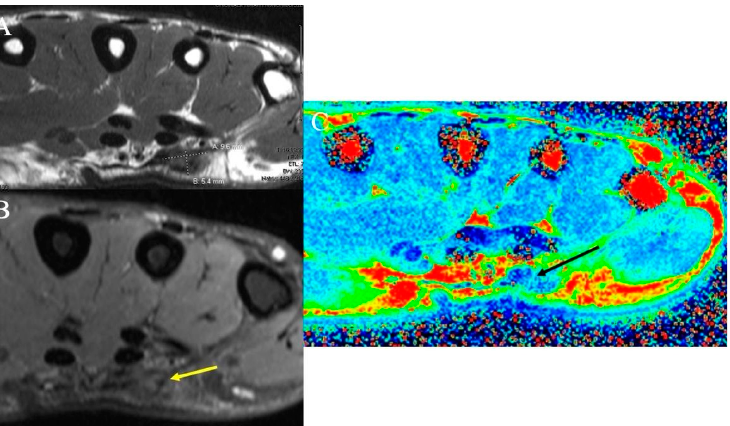
Figure 10. Dupuytren’s disease. ( A ) Axial T1-weighted MR image demonstrating a low-signal mass measuring 9.6 mm × 5.4 mm consistent with the diagnosis of superficial palmar fibromatosis or Dupuytren’s disease. ( B ) Axial fat ‐ suppressed PD ‐ weighted MR image demonstrating the low ‐ signal nodule (yellow arrow); high collagen content within the nodule results in the relative hypointensity of superficial fibromatosis. ( C ) Axial color ‐ coded T2 map MRI demonstrates the nodule (black arrow) as reflecting tissue with decreased T2 relaxation times (blue color), the characteristic of collagen ‐ rich fibromatosis.